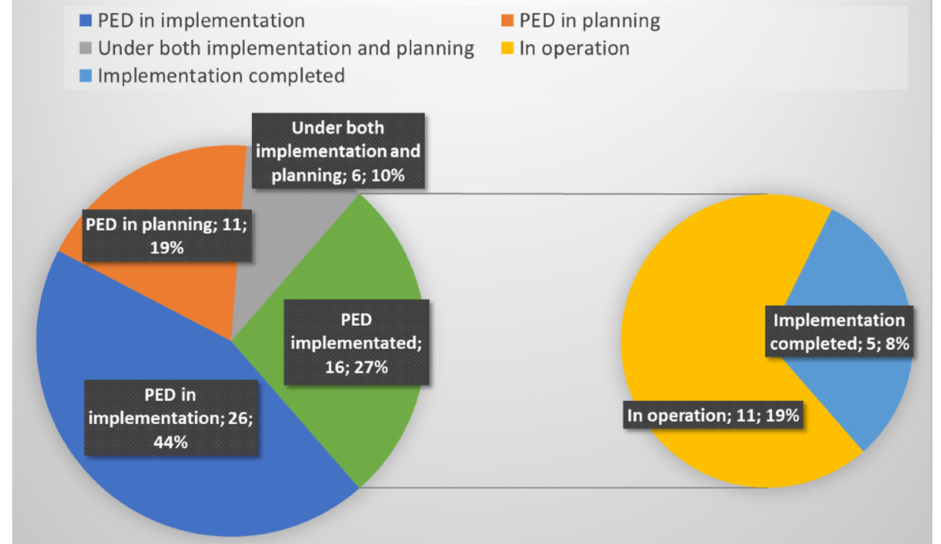
Figure 3. Development stage of collected 60 PED related